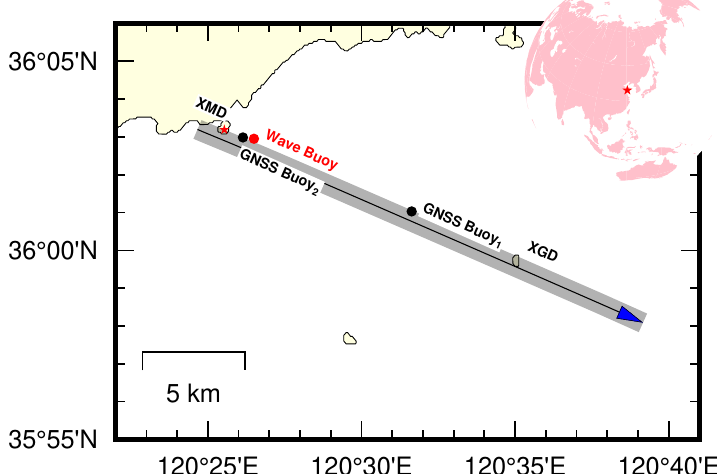
Figure 1. Map of the AIRAS experiment area around the station XMD, Qingdao, China. GNSS buoy 1 and buoy 2 were deployed at sea, separated by a distance of 9 km. Buoy 1 was moved to the location of buoy 2 after the AIRAS campaign was completed to cross validate the measurements of the GNSS buoys and tide gauges.